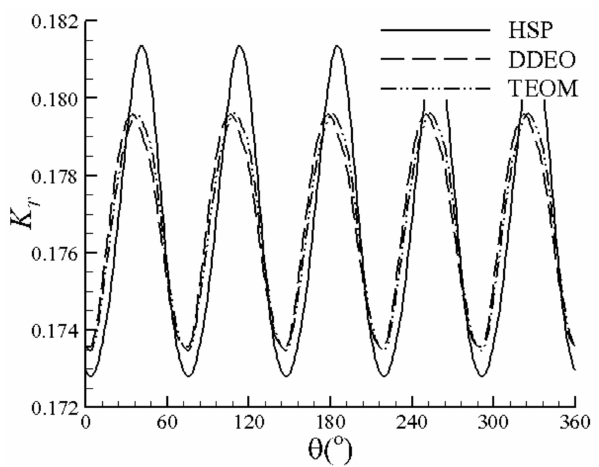
Figure 8. Variation in KT in one rotation cycle.